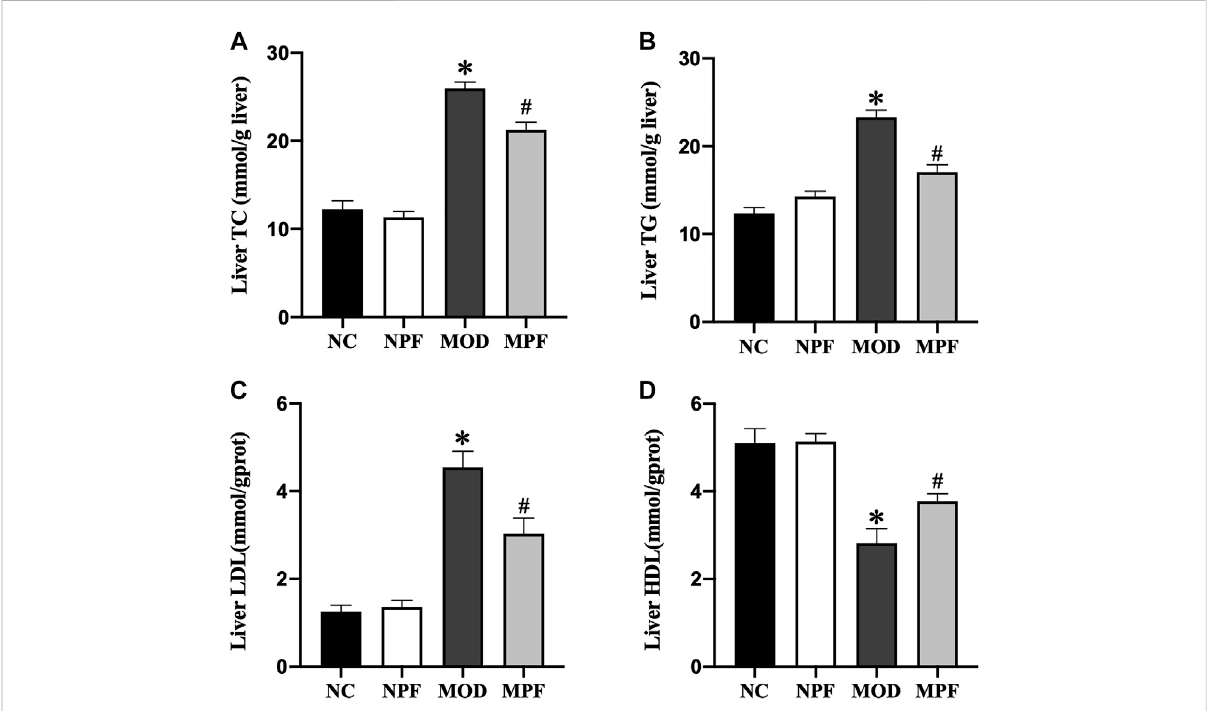
Effects of paeoni fl orin (PF) on lipids in the liver. Hepatic levels of (A) TC, (B) TG, (C) LDL, and (D) HDL. The liver samples were obtained from the normal control group (NC), PF-treated control group (NPF), model group (MOD), and PF-treated model group (MPF). Data are presented as